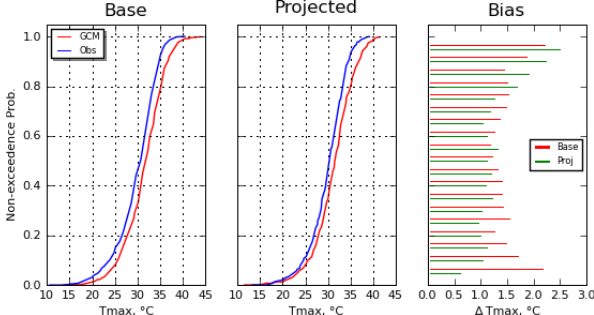
Fig. 2. Comparison of cumulative distribution functions of daily summer (JJA) maximum temperature between a GCM (NCAR CCSM3 in this case) and observations for a single grid point at 39 ◦ N, 121 ◦ W (cell 2 in Fig. 1). Base set is a 20yr random sample from 1950–1999 (left panel); projected is a different 10yr random sample from the same period (center panel), and bias (right panel) is calculated at 19 evenly spaced quantiles (0.05, 0.10, ...,